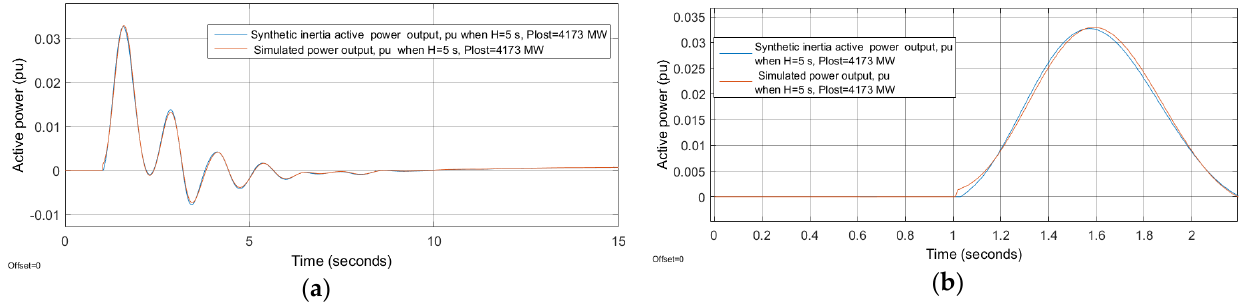
Figure 6. Comparison of active power outputs of the SI algorithm and simulated power output when H = 5 s and there is 4173 MW loss of generation. ( a ) Modeling result displayed in 15 s scale; ( b ) the same modeling results displayed in 2 s.